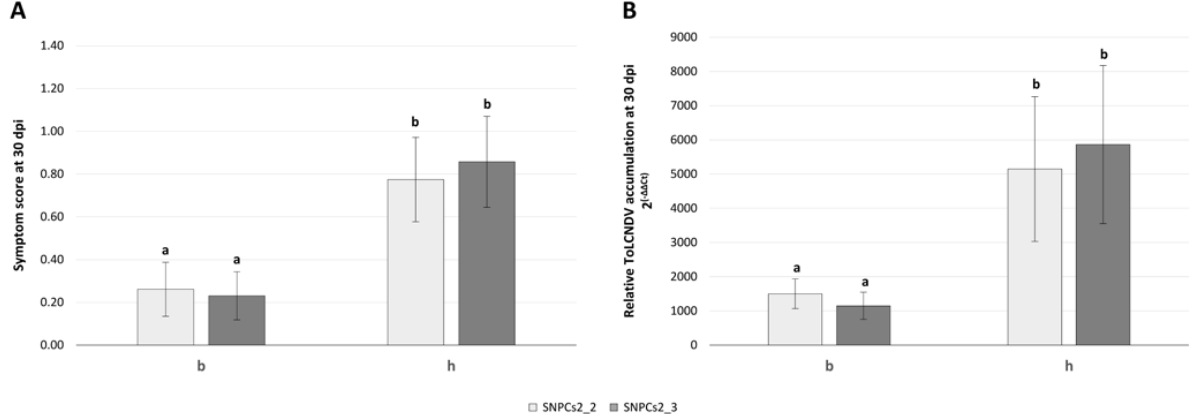
Figure 6. Mean of symptom score ( A ) and relative viral accumulation ( B ) at 30 days after mechanical inoculation in 6 BC BGV011742 according to each genotypic class of SNPCs2_2 and SNPCs2_3 markers (chromosome 2). On the x axis, homozygous genotype of CGN23089 allele is represented as “b”, heterozygous genotype is represented as “h”. Bars with same letter are not significantly different at p ≤